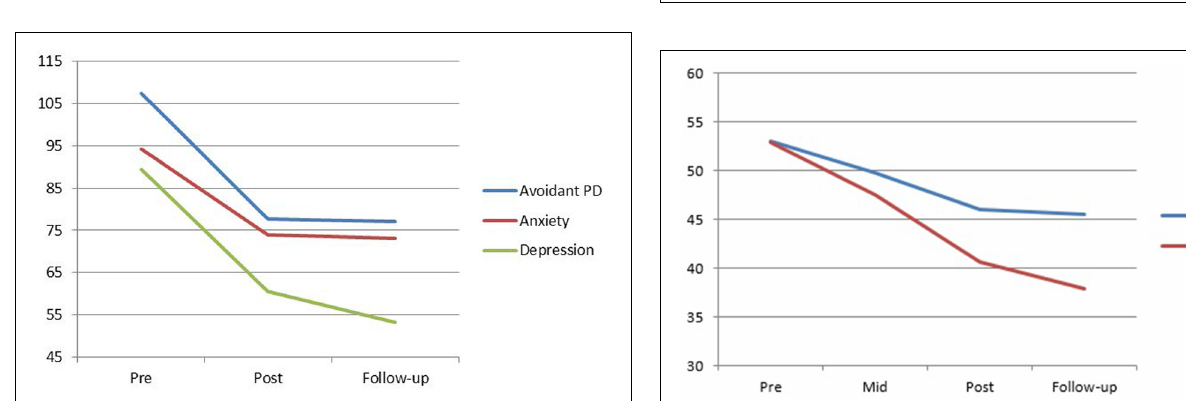
FIGURE 3 | SMI adaptive modes group means from pre-treatment through mid-, post-, and follow-up.